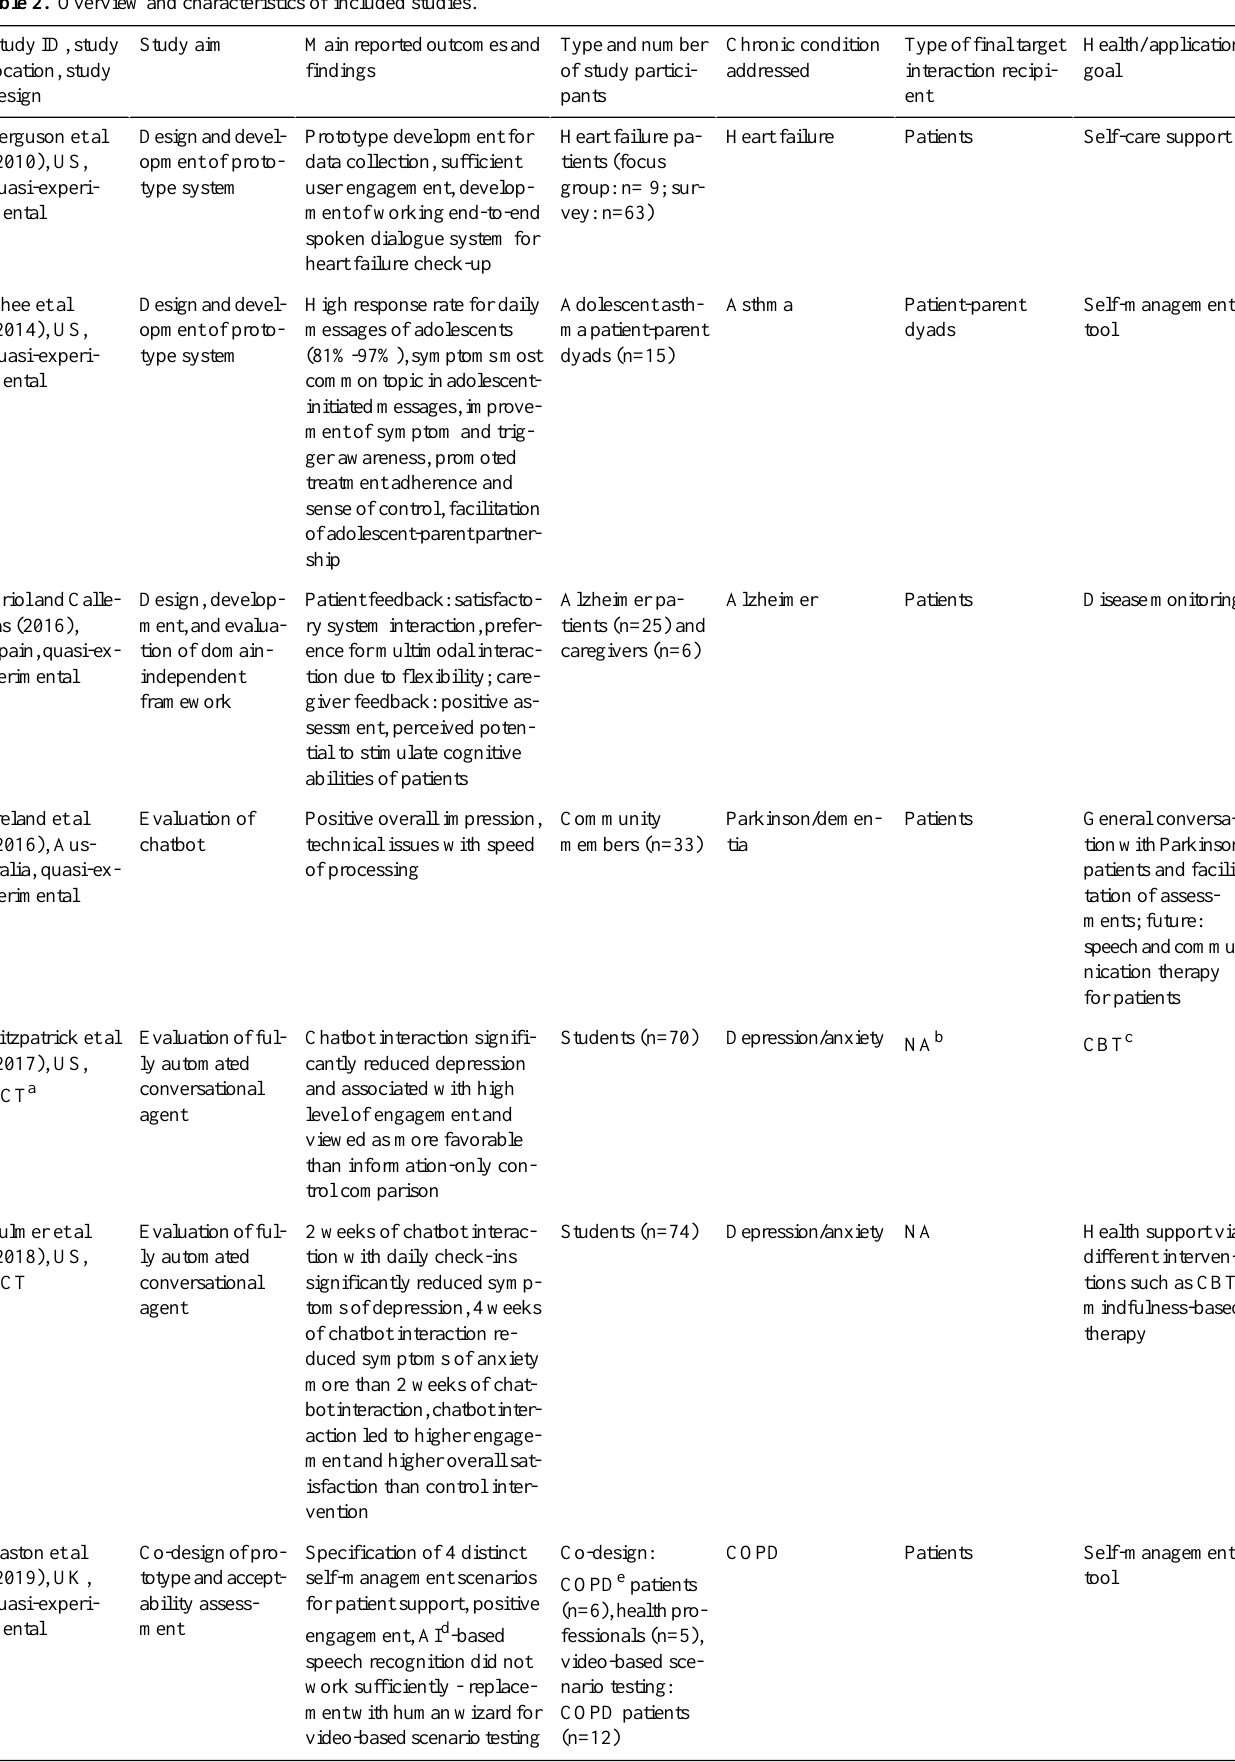
Table 2. Overview and characteristics of included studies.